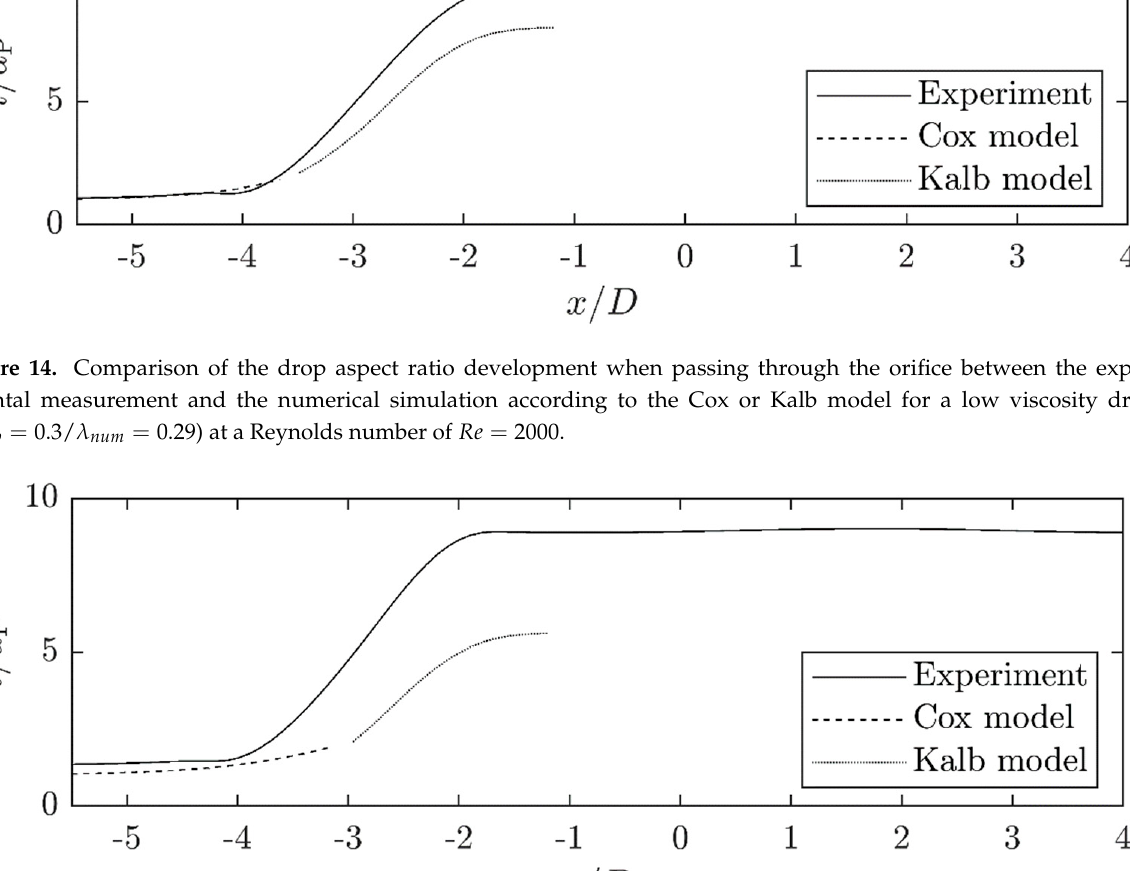
Figure 14. Comparison of the drop aspect ratio development when passing through the orifice be ‐ tween the experimental measurement and the numerical simulation according to the Cox or Kalb (cid:3404) 0.3 / 𝜆 (cid:3404) 0.29 ) at a Reynolds number of 𝑅𝑒 (cid:3404) 2000 . model for a low viscosity drop ( 𝜆 (cid:3032)(cid:3051)(cid:3043) (cid:3041)(cid:3048)(cid:3040)